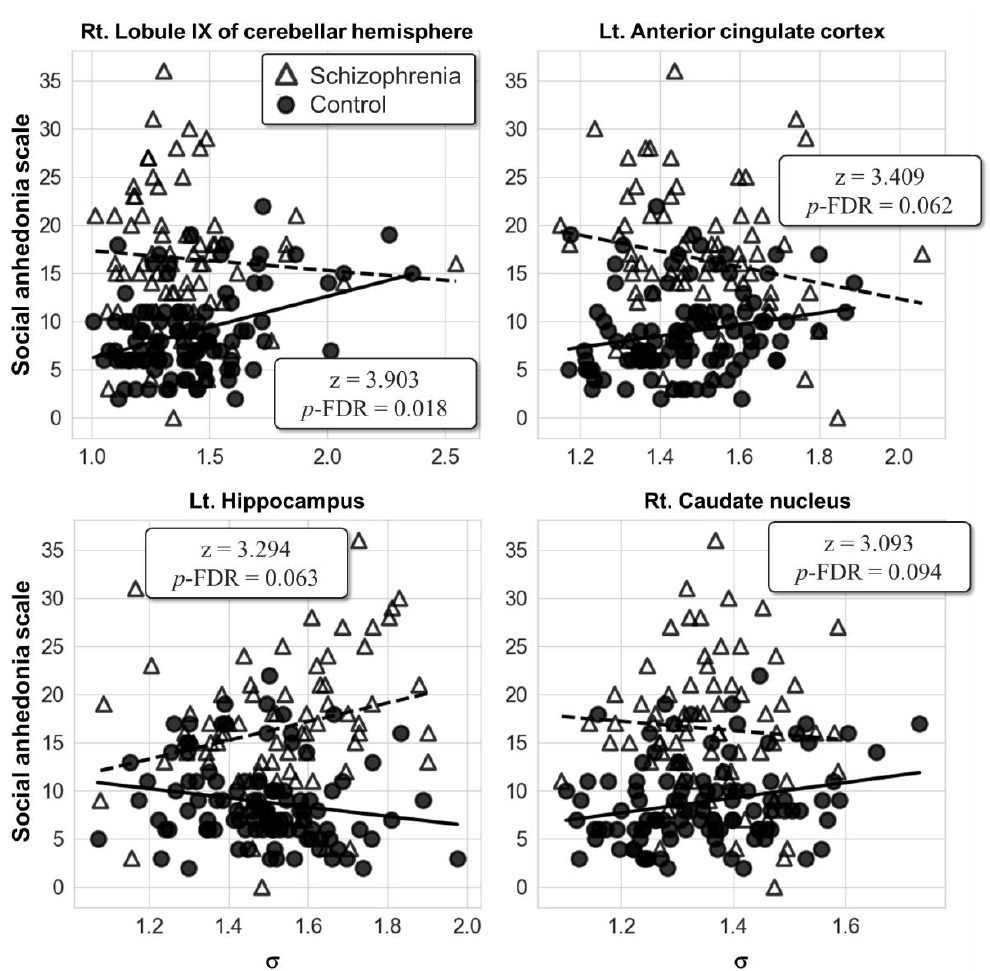
Figure 3. Scatter plots showing the relationships of the social anhedonia scale (SAS) score with the small-worldness metric σ from the results of the automated anatomical labeling (AAL)-level local-scale analysis. Abbreviation: Lt., left; Rt., right; FDR, false discovery rate.